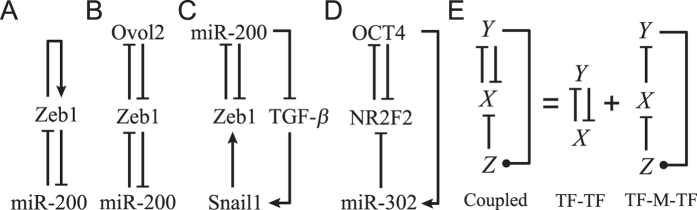
Interlinked feedback loops.(A–D) Examples of miRNA-containing circuits where two loops share one (A,B) or two (C,D) components. (E) The model. The system of coupled feedback loops can be decomposed into two loops. The arrow- and bar-headed lines denote activation and inhibition, respectively, while circle-headed lines denote either activation or inhibition.